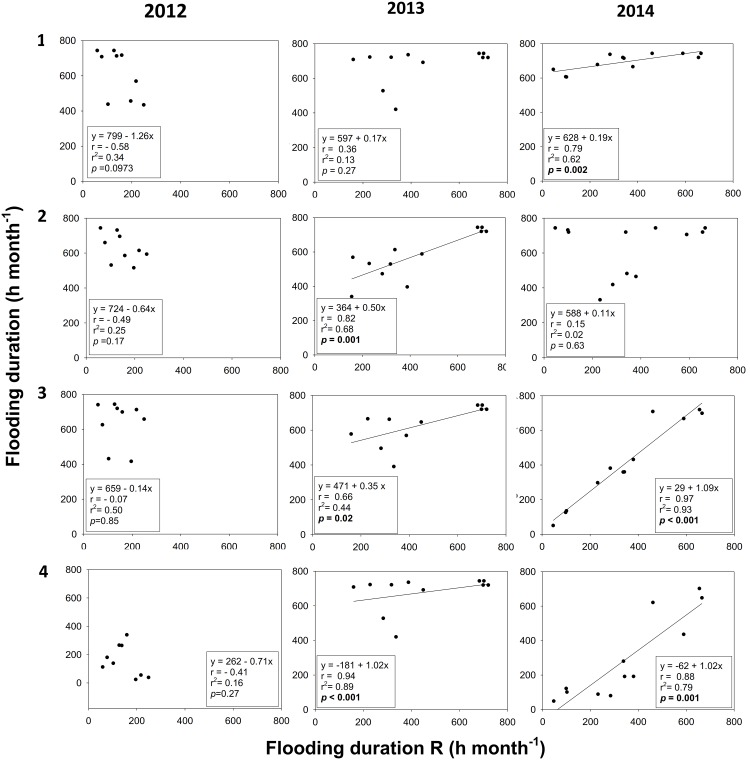
Linear regressions comparing flooding duration in the impaired sites 1, 2, 3 and 4 vs. the reference site (R) in 2012 (left panels), 2013 (central panels) and 2014 (right panels).